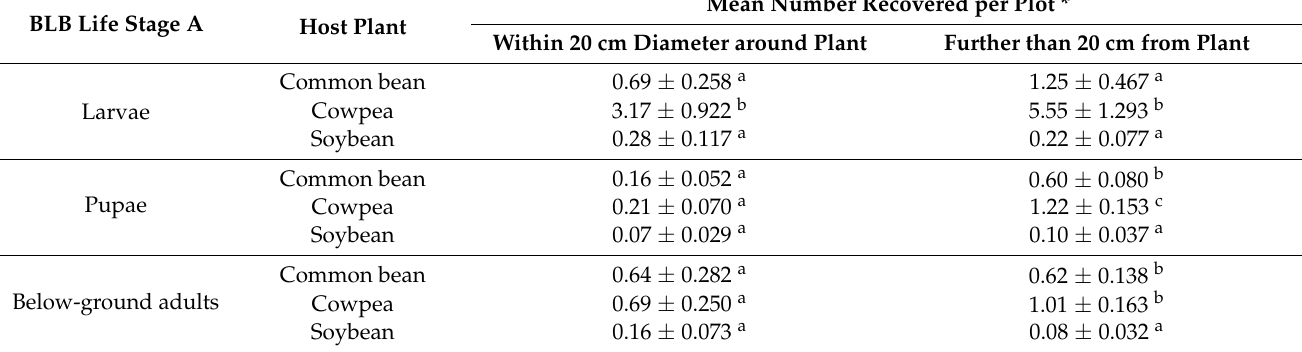
Table 2. Mean number of larvae, pupae, and below-ground adults of Ootheca spp. recovered within and further than 20 cm around the crop in plots of different host